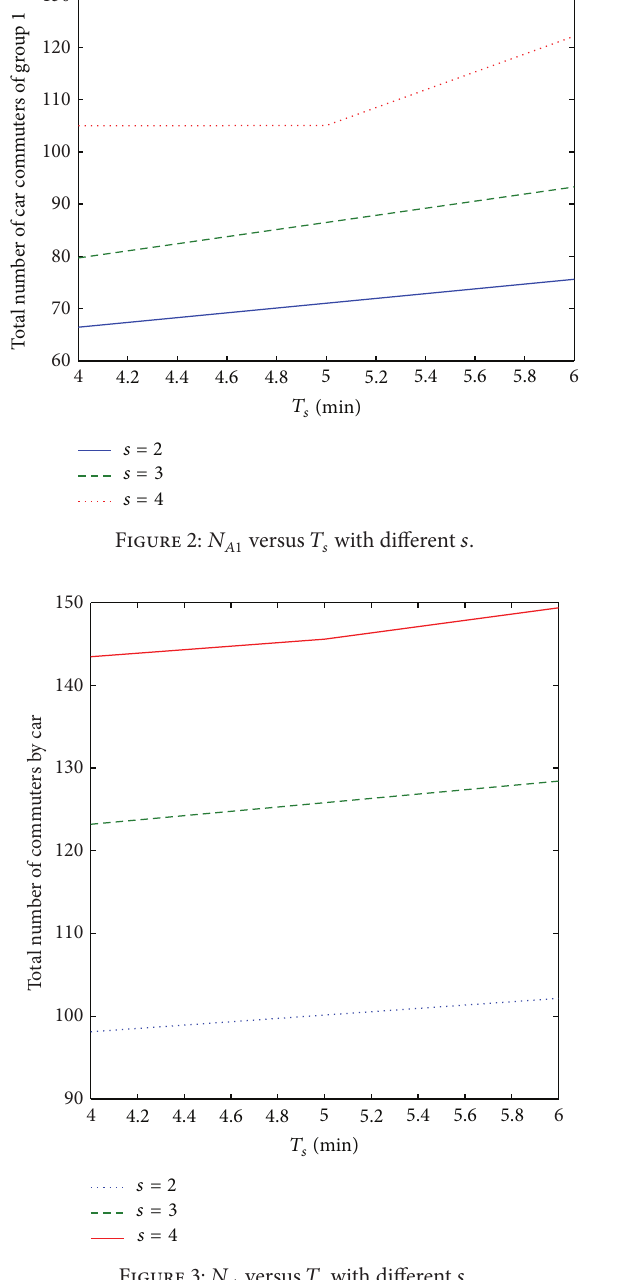
Figure 3: 𝑁 𝐴 versus 𝑇 𝑠 with different 𝑠 .